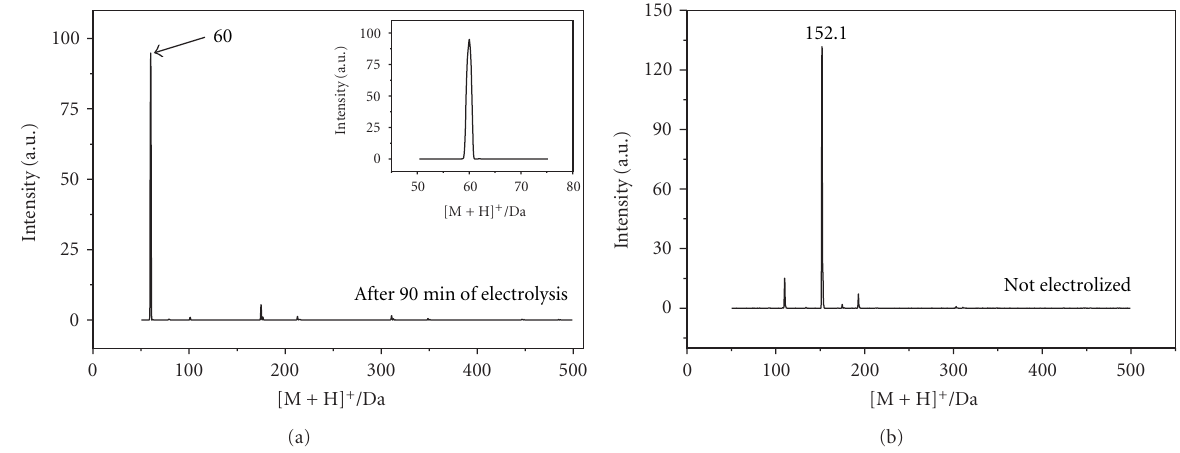
Figure 8: (a) Mass spectrum of the UPLC chromatographic peak corresponding to the retention time of 0.40minutes in Figure 7(e). The inset shows a better view of the value of the [M+H] + , which suggests that the compound is acetamide. (b) Mass spectra of the UPLC chromatographic peak at retention time of 0.45min, corresponding to paracetamol for samples collected before the